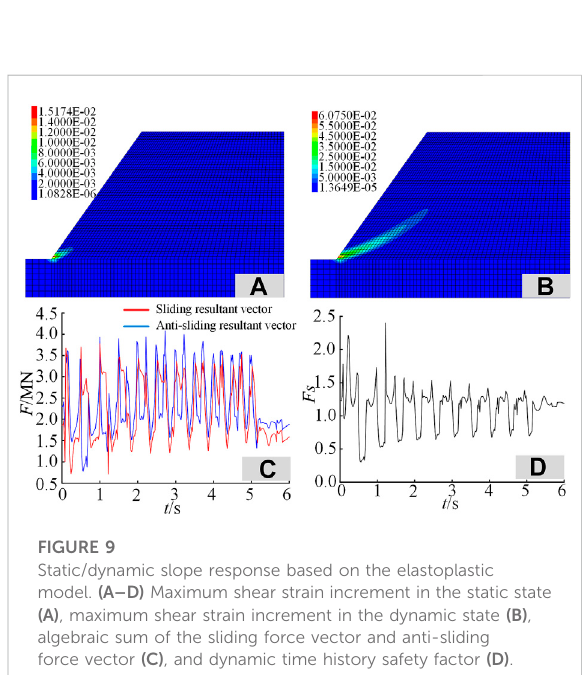
FIGURE 10 Dynamic response of slope based on the strain-softening model. (A – F) Maximum shear strain increment in the dynamic state (A) , change of cohesion (B) , change of internal friction angle (C) , change of tensile strength (D) , algebraic sum of the sliding force vector and anti-sliding force vector (E) , and dynamic time history safety factor (F)